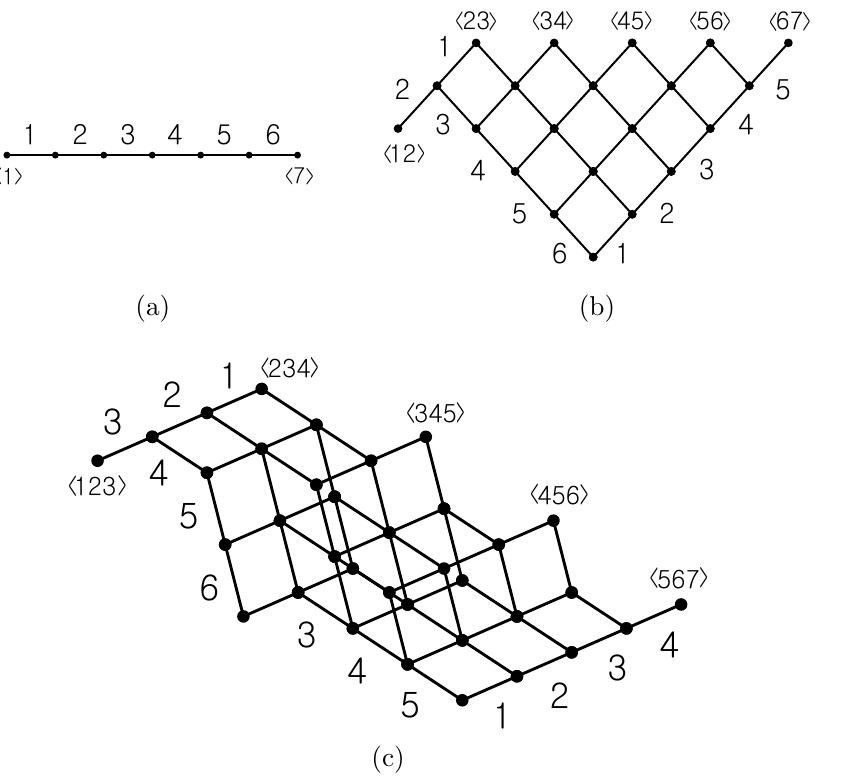
Figure 1 . Vacua and elementary walls in G 7 ;N . The numbers indicate the subscript i ’s of simple roots (cid:11) . (a) G 7 ; 1 (b) G 7 ; 2 (c) G 7 ; 3 i